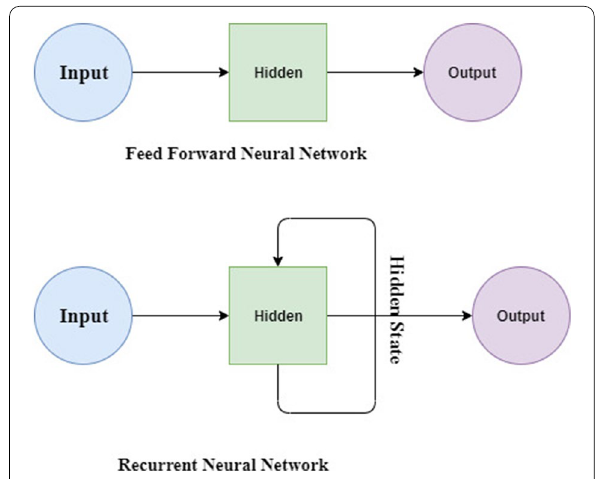
Figure 1 Basic Feed-Forward Neural Network structure and Recurrent Neural Network